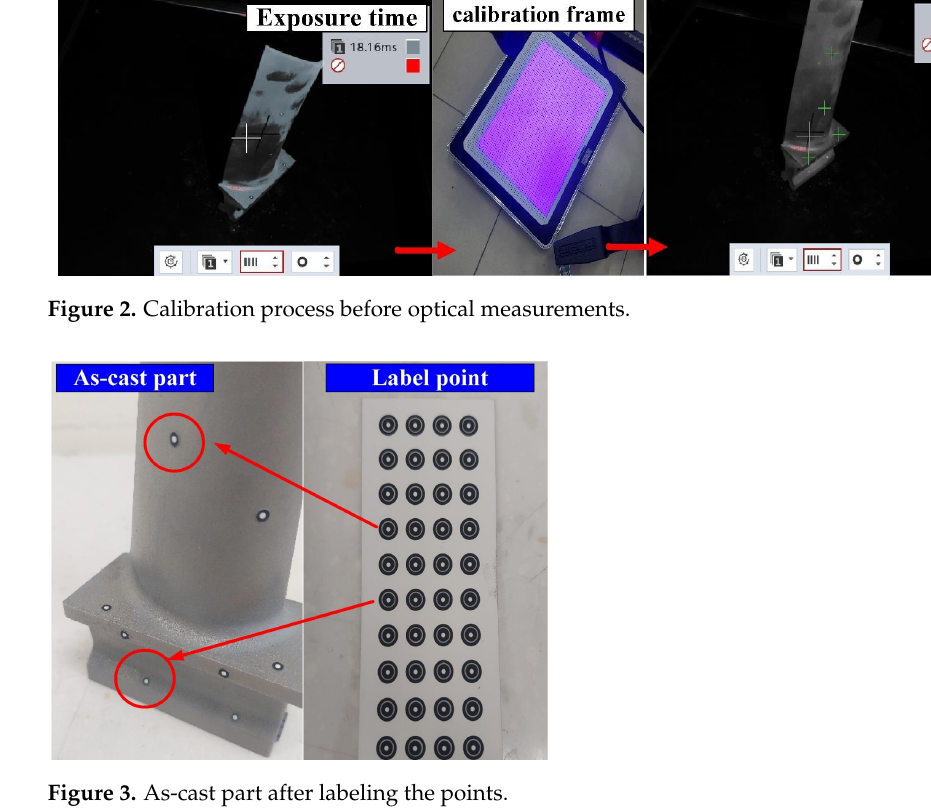
Figure 3. As-cast part after labeling the points.